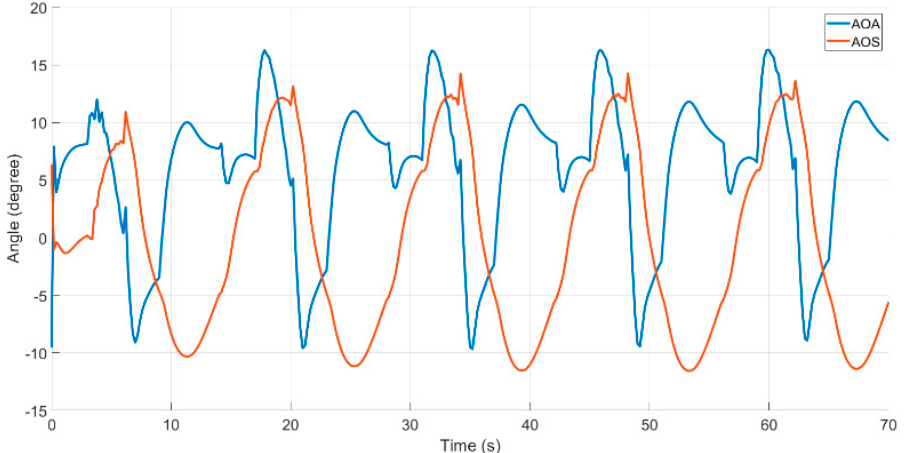
Figure 15. The aerodynamic angles change during the dynamic soaring.